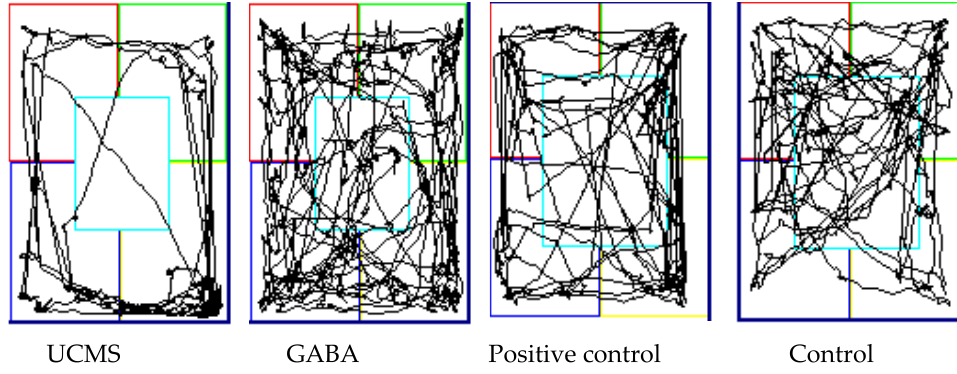
Figure 5. Path map of mice in open field test.